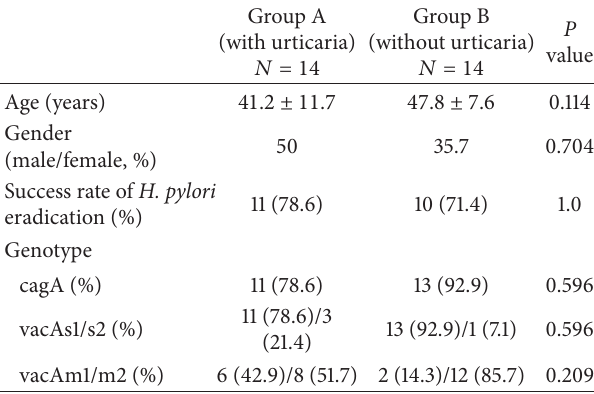
Figure 1: Allocation diagrams of patients with chronic spontaneous urticarial. Table 1: Demographic data of H. pylori -infected patients with or without chronic spontaneous urticaria